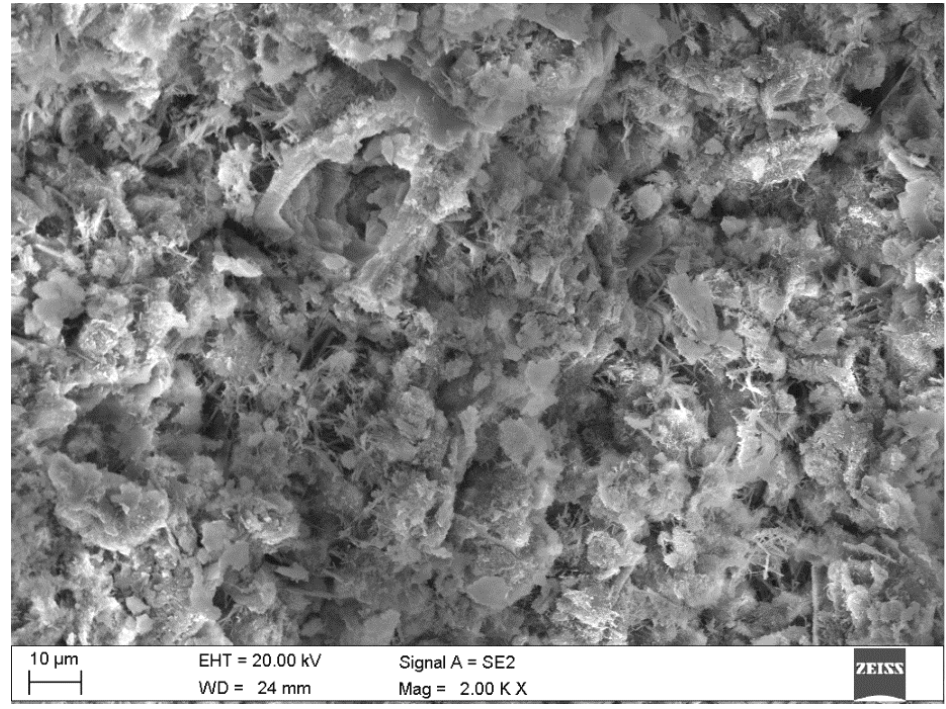
Figure 13. Disintegrated, loosened, non-cohesive sample matrix of B-25 at a depth of 3.5 mm.